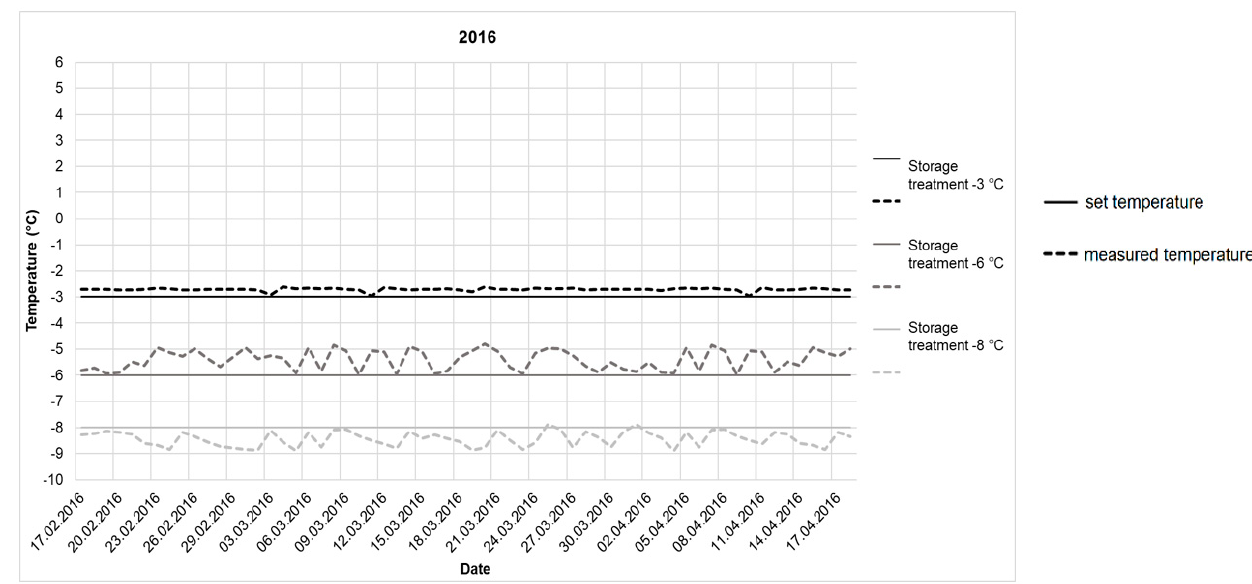
Figure 1. Air temperature during storage of the tested plants in 2016.